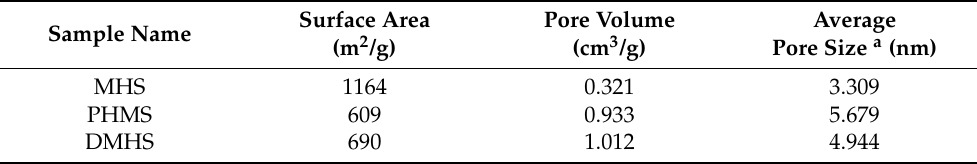
Table 1. The textural properties of the MHS, PHMS, and DMHS.